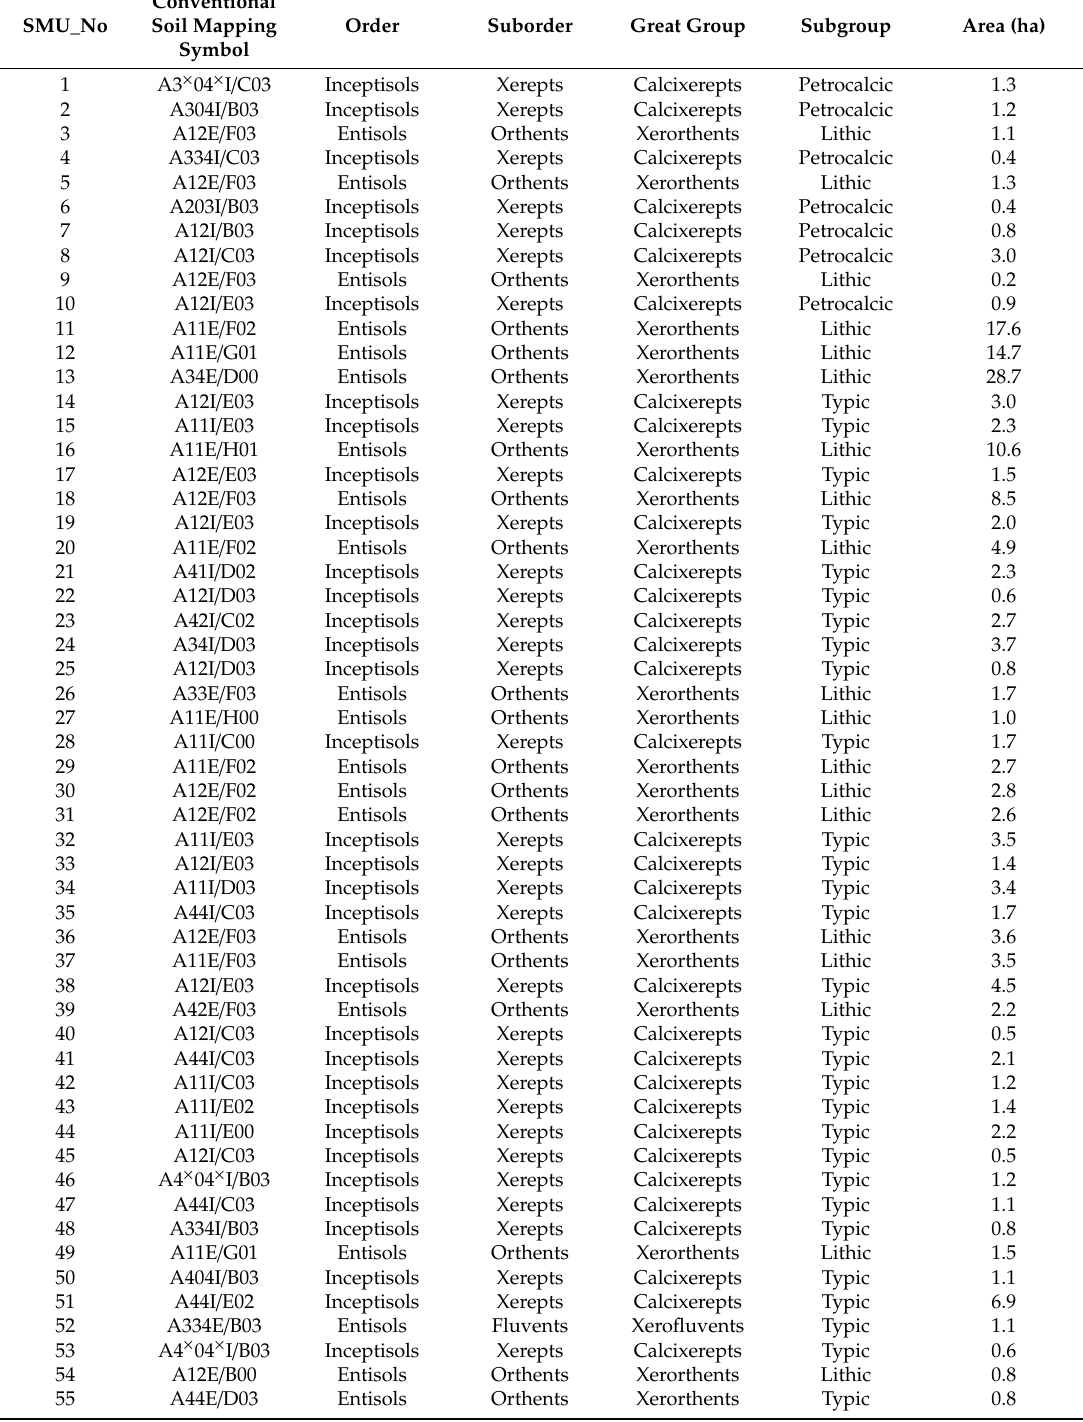
Table A8. SMU numbering, symbolization, occupied area and soil’s taxonomy of the conventional methodology (1976 mapping